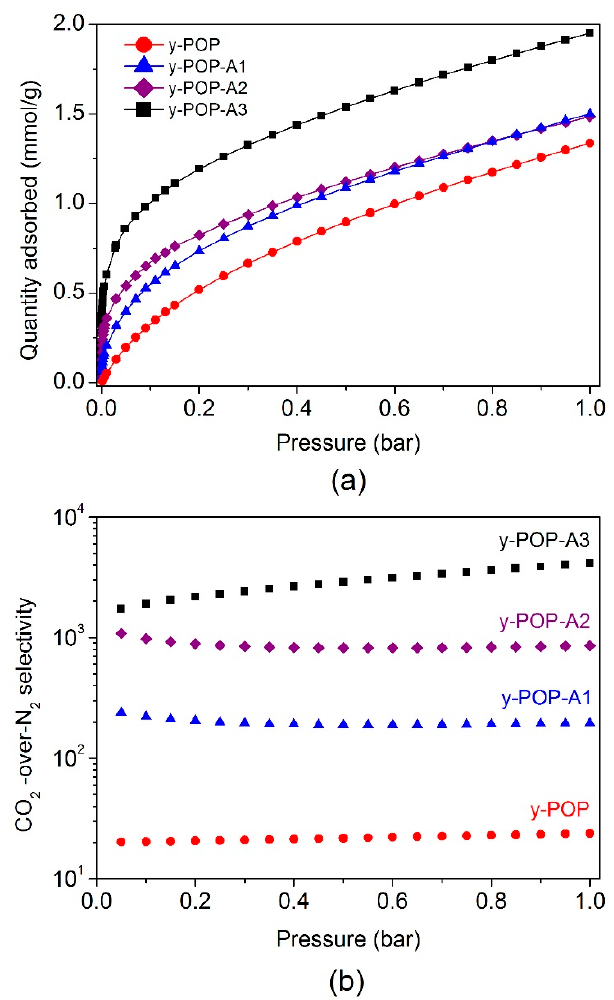
Figure 4. ( a ) CO 2 adsorption isotherms of ynone-linked porous organic polymer (y-POP) and y-POP- y-POP-NH 2 withdi ff erentamineloadingsat273K;( b )CO 2 -over-N 2 selectivityofy-POPandy-POP-NH NH 2 with different amine loadings at 273 K; ( b ) CO 2 -over-N 2 selectivity of y-POP and y-POP-NH 2 calculated by ideal adsorbed solution theory.